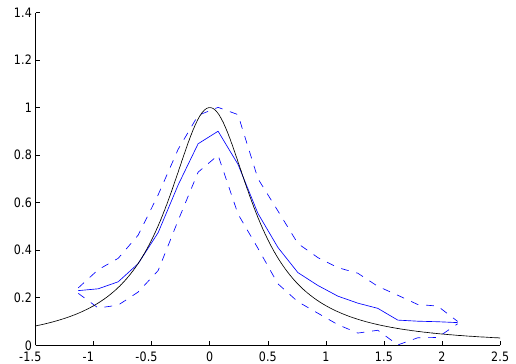
Fig. 7. Non-parametric estimation of the self-regulating function for the process shown in Fig. 4. Abscissas are amplitude and ordinates are pointwise regularities. True g function (black), non-parametric estimation (blue) and 95% confidence interval (dotted lines).